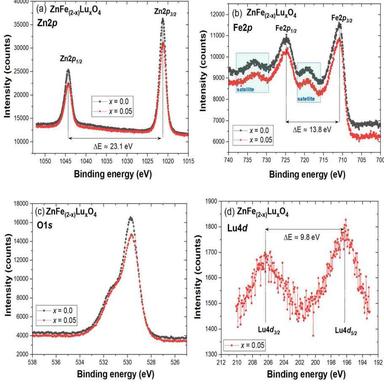
The XPS core level lines (a) Zn2p, (b) Fe2p, (c) O1s and (d) Lu4d for ZnFe(2-x)LuxO4, where x = 0.0 (Lu 0.0) and 0.05(Lu 0.05).